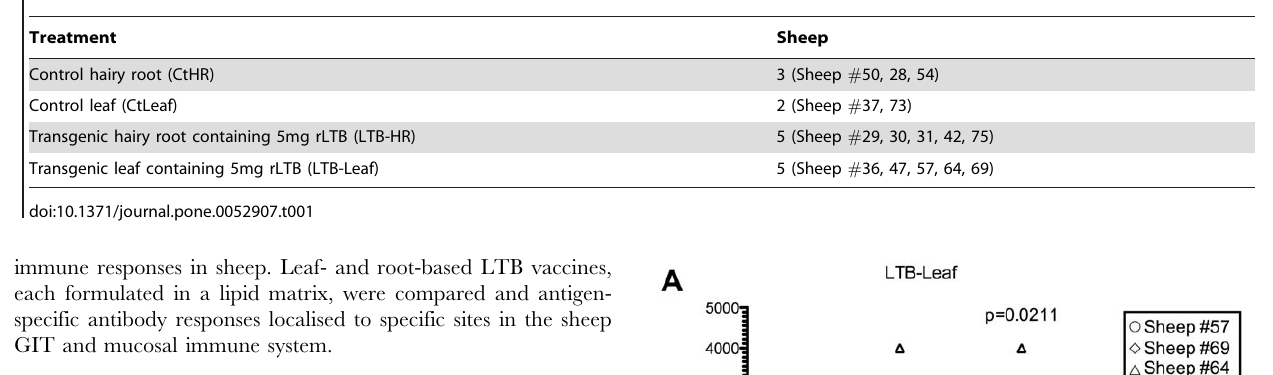
Treatment Sheep